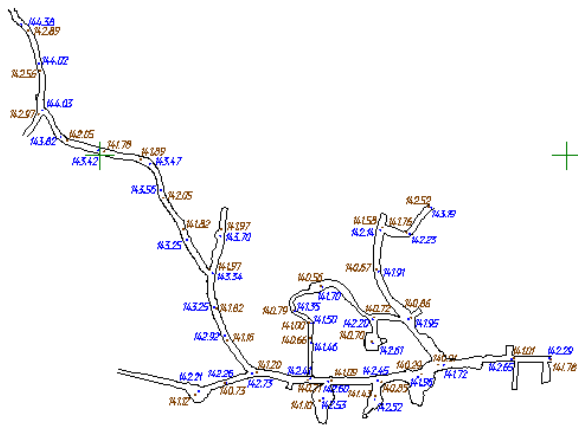
Fig. 15. A sample of caves plan with